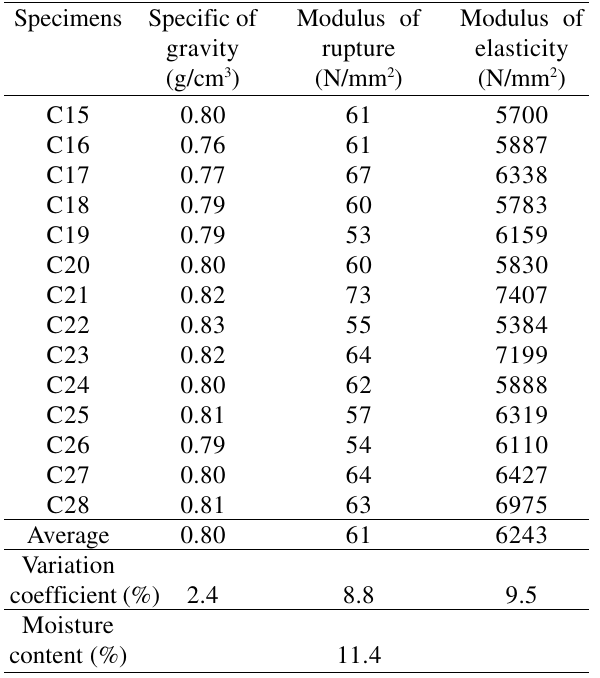
Table 3. Results in the tests for direction perpendicular to the grain of the external layers.